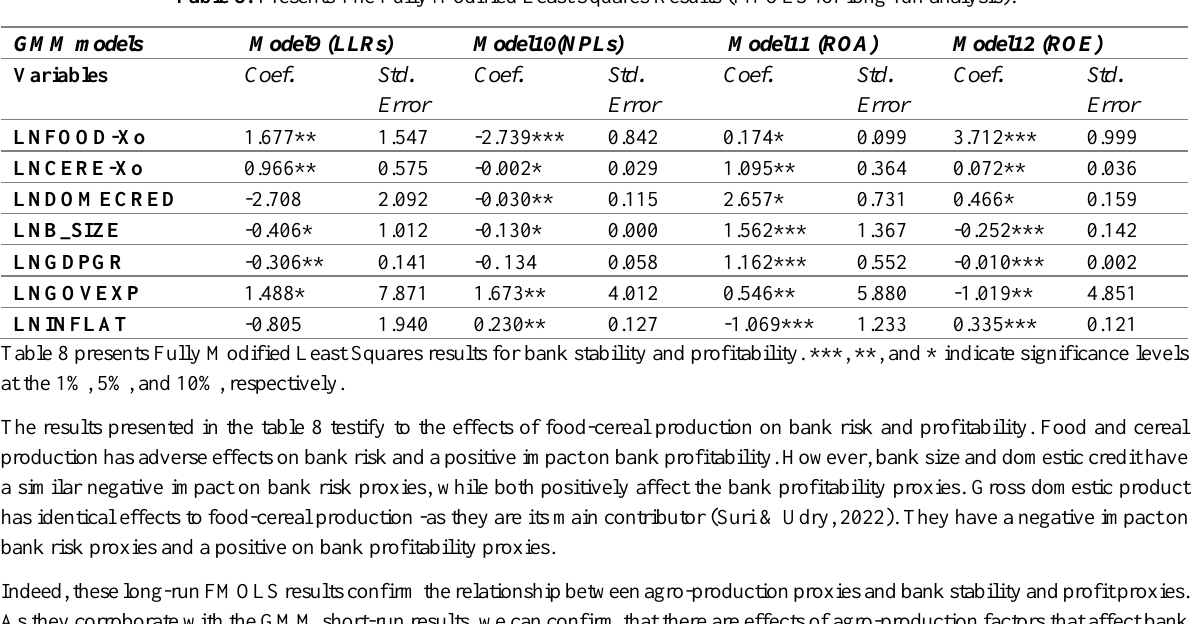
Table 8: Presents The Fully Modified Least Squares Results (FMOLS for long-run